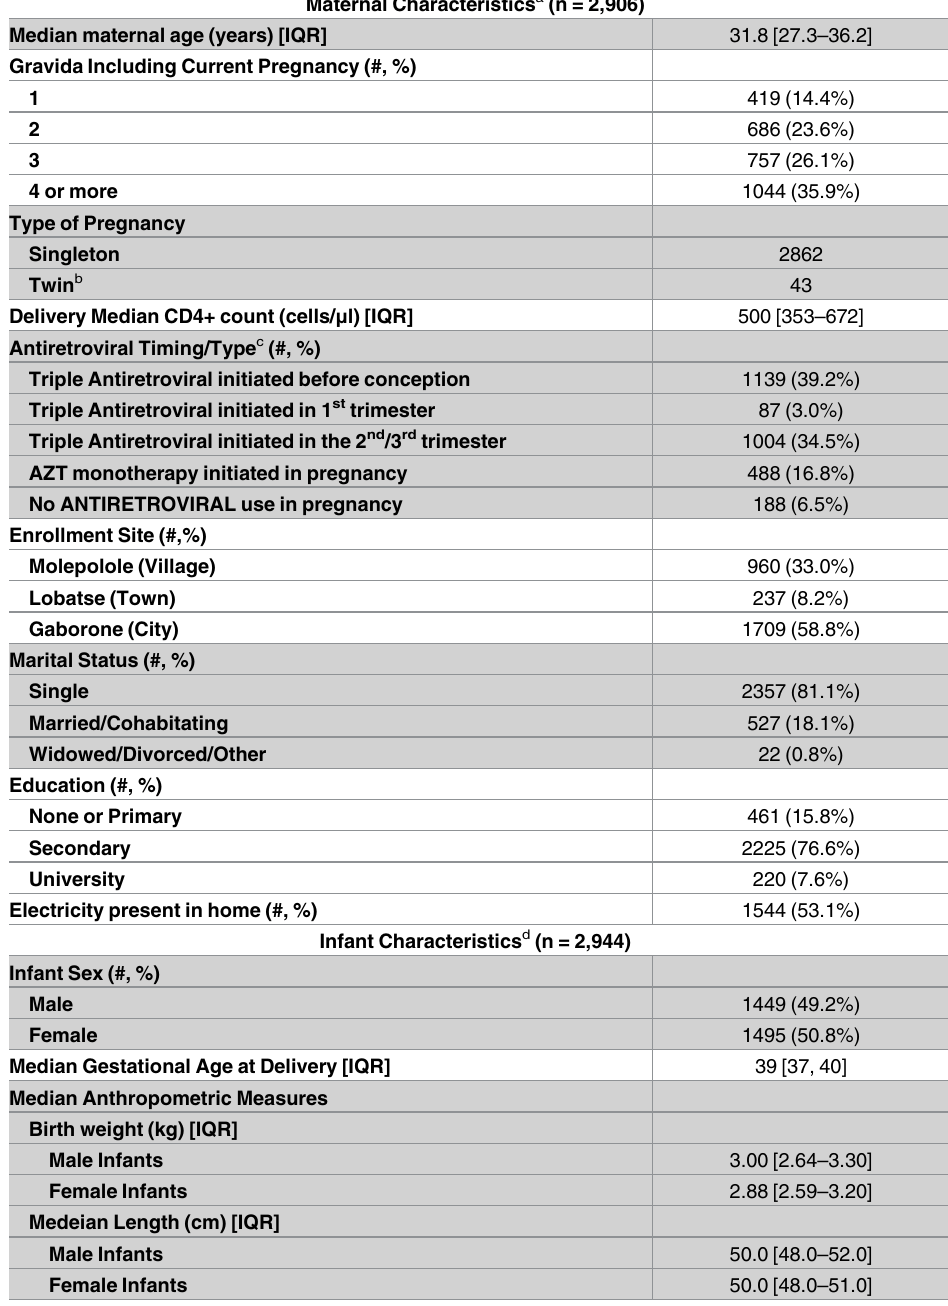
Table 1. Maternal-Infant